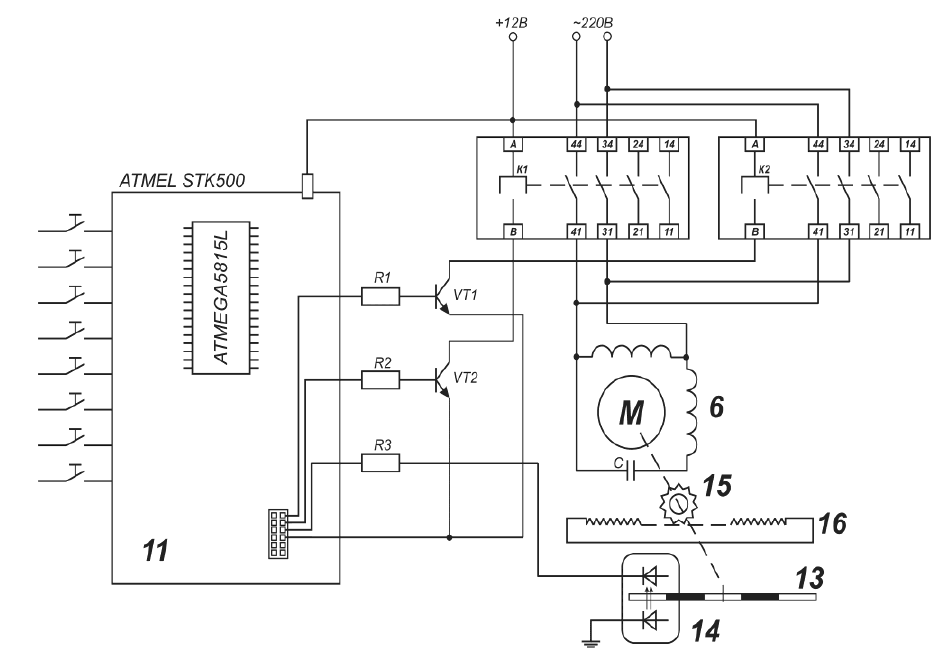
Figure 2. Electric principle diagram of the sampling system.